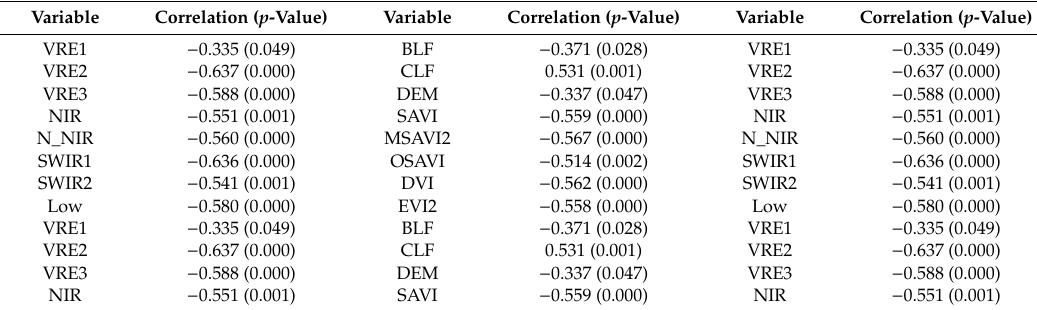
Table 7. Variables significantly correlated with all-type vegetation